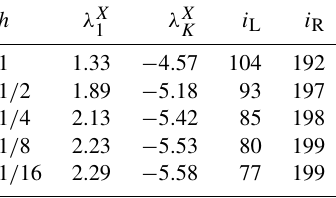
Table 1. X -restricted largest ( λ X corresponding full spectrum indices ( i L and i R ). All data refer to b = 10, K = 36 and J =